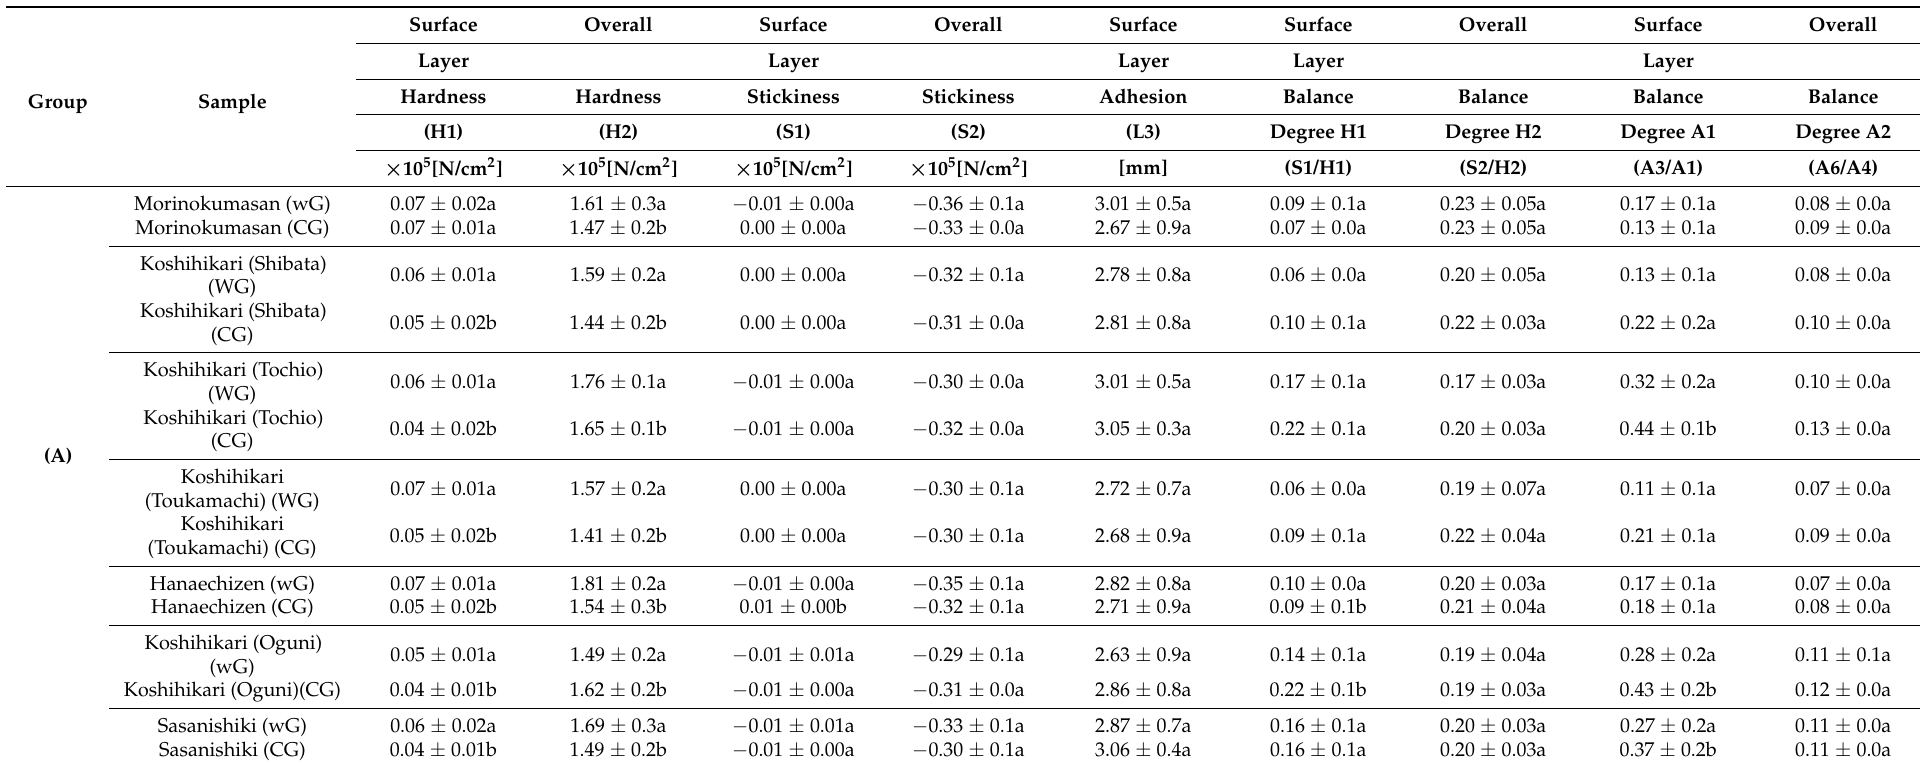
Table 4. Physical properties of cooked whole and chalky rice grains from 7 Japonica rice samples in